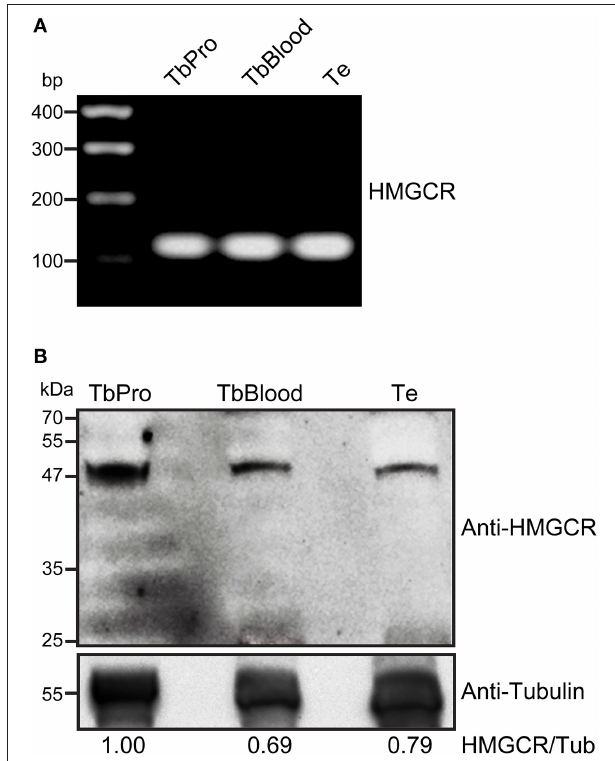
FIGURE 5 | T. evansi expresses HMGCR at RNA and protein levels. (A) Presence of HMGCR mRNA in T. evansi , T. brucei procyclic form, and T. brucei bloodstream form, revealed by RT-PCR. HMGCR gene fragment contained 128 bp. Amplified fragments were sequenced and analyzed using DNASTAR Lasergene EditSeq for sequence confirmation. (B) Thirty micrograms of protein extracts of T. brucei procyclic form (TbPro), T. brucei bloodstream form (TbBlood) and T. evansi (Te) were subjected to SDS-PAGE and blotted using anti-human HMGCR. Anti-tubulin was used as loading control. Numbers refer to the densitometric ratio between HMGCR/tubulin.